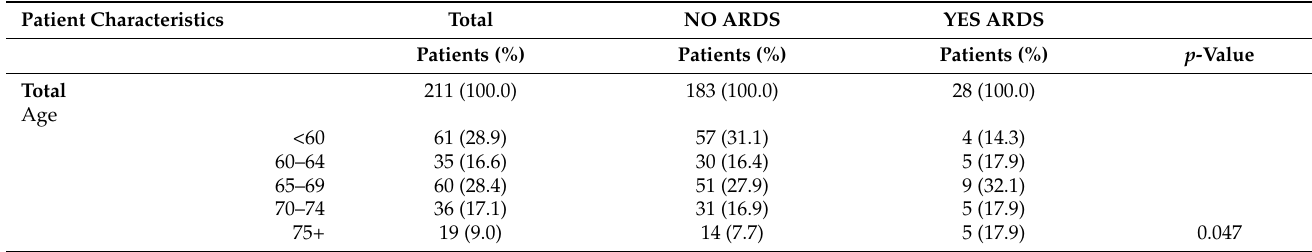
Table 1. Clinical factors associated with development of